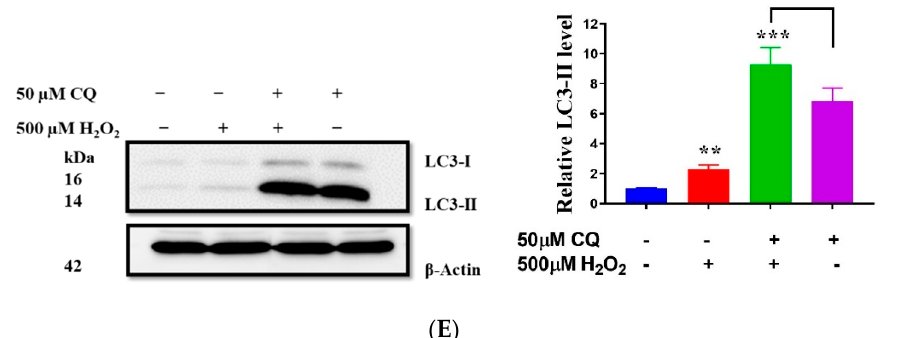
Figure 3. Differential effects of hydroquinone (HQ) and H 2 O 2 on autophagy flux in ARPE-19 cells. ( A ) Increased GFP-LC3 puncta indicating the accumulation of autophagosomes in cells transfected with the GFP-LC3 plasmid and incubated with HQ or H 2 O 2 for 2 h. ( B , C ) Immunoblot showing a dose-dependent increase in the autophagy marker LC3-II in ARPE-19 cells treated with HQ or H 2 O 2 for 2 h. ( D , E ) Autophagy flux in cells with chloroquine (CQ) pretreatment for 8 h, followed by incubating with HQ or H 2 O 2 for 2 h. Densitometry quantification of protein levels was normalized with β -actin and expressed as a ratio relative to the control. Data represent the mean + SD of 3 independent experiments of 3 replicates each. Statistical analysis using one-way ANOVA followed by Sidak or Dunnett’s multiple comparison test. ** p < 0.01, *** p < 0.001 vs control, significant difference relative to the controls.